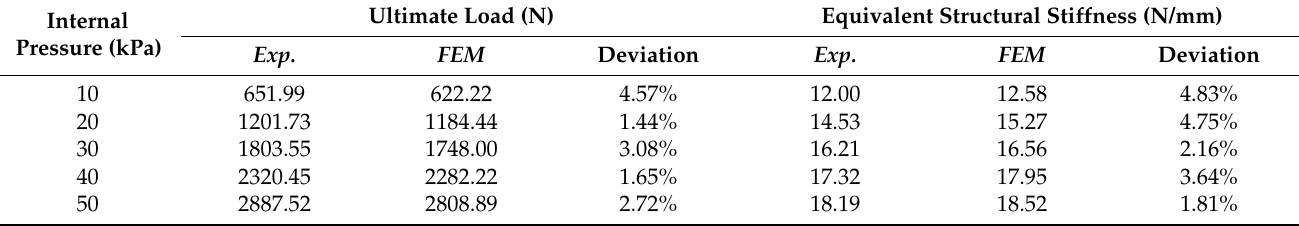
Table 3. Values and deviations for numerical and experimental results of the ultimate load and the equivalent structural